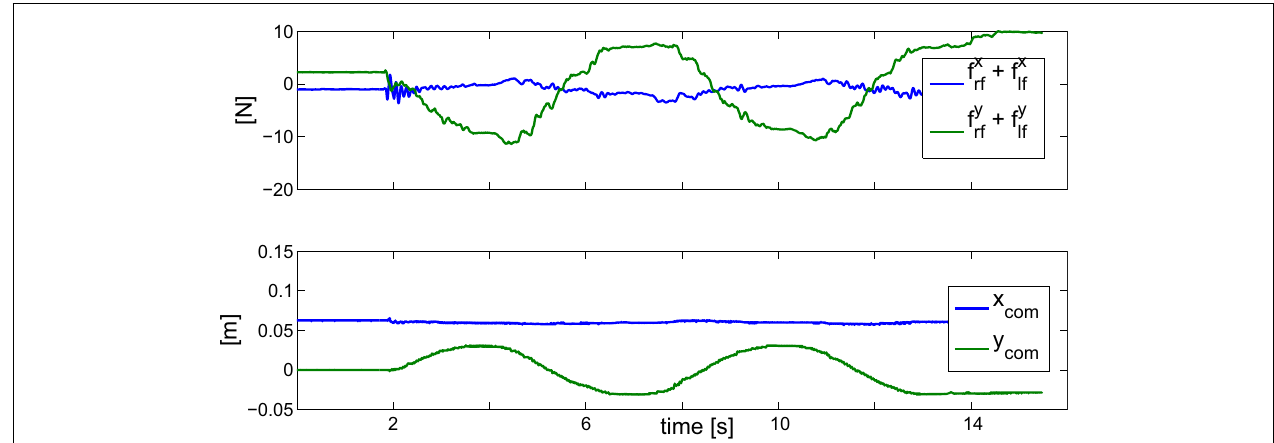
accelerations and this is visible in the plot considering that accelerations are sinusoidal in counter phase with positions. Rapid variations of the contact forces at the time t ≈ 2[s], i.e., starting time, are due to the activation of the torque control.